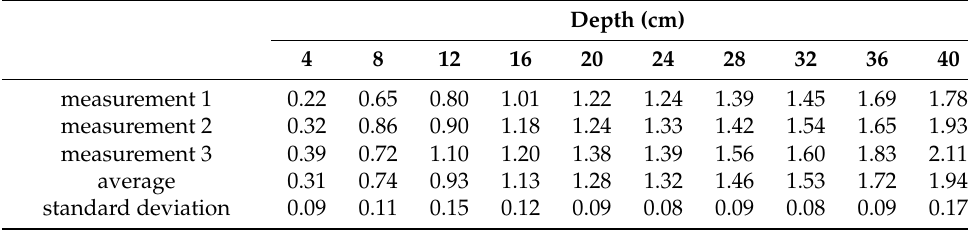
Table 2. Penetrometer resistance